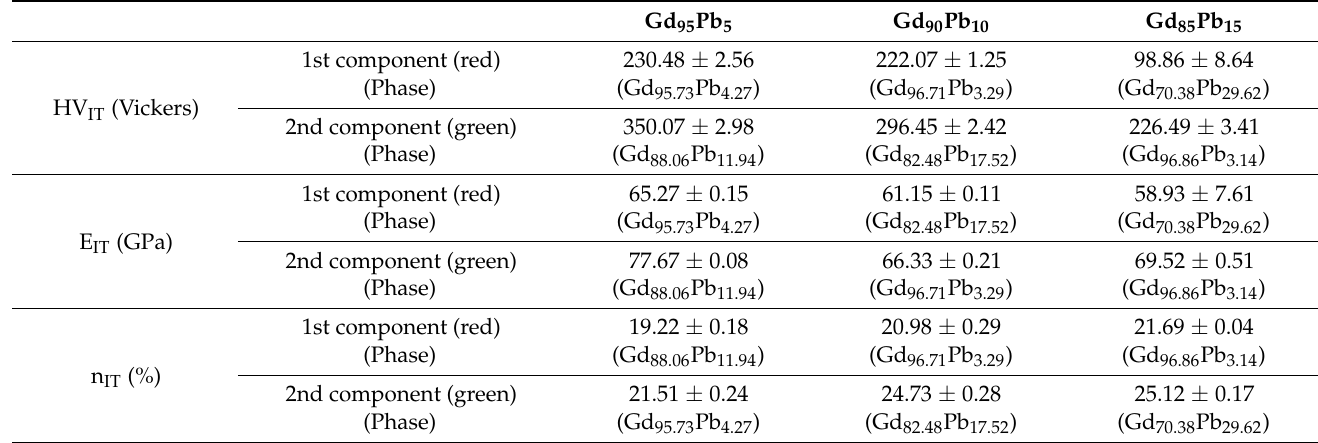
Table 6. Hardness (HV IT ), Young’s modulus (E IT ) and elastic to total energy deformation ratio (n IT ) for the individual phases observed in the Gd 95 Pb 5 , Gd 90 Pb 10 and Gd 85 Pb 15